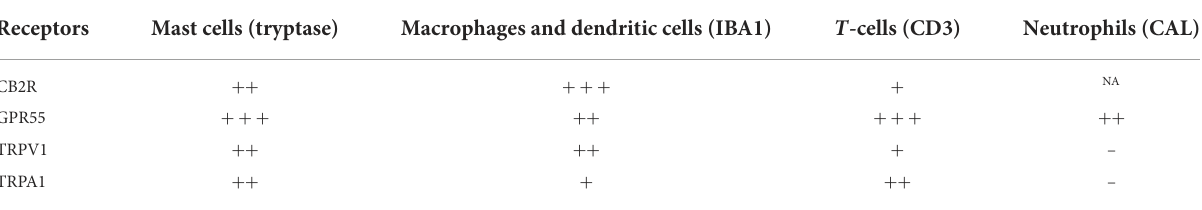
TABLE 4 Semiquantitative evaluation of the density of CB2R, GPR55, TRPV1, and TRPA1 immunoreactivity in different cellular elements of the skin of dogs with atopic dermatitis (AD-dogs).